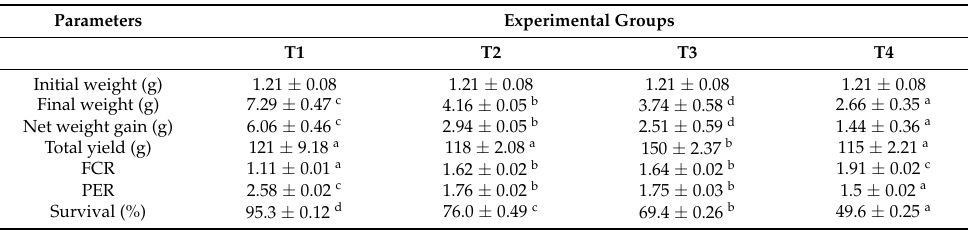
Table 2. Growth performance and feed utilization of O. bimaculatus seed reared in biofloc system at different stocking densities for 90 days.